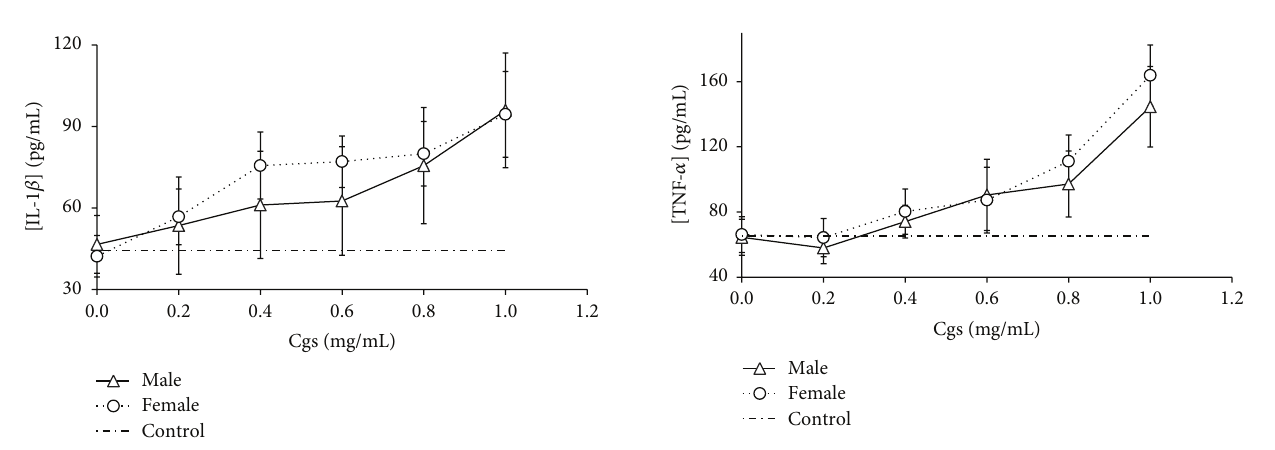
Figure 1: Increase in IL-1 𝛽 concentration (pg/mL) in culture med- ium after the 24-hour incubation of PBMCs from male and female healthy subjects with Cgs isolated from the blood of male and female SCZ patients, respectively.